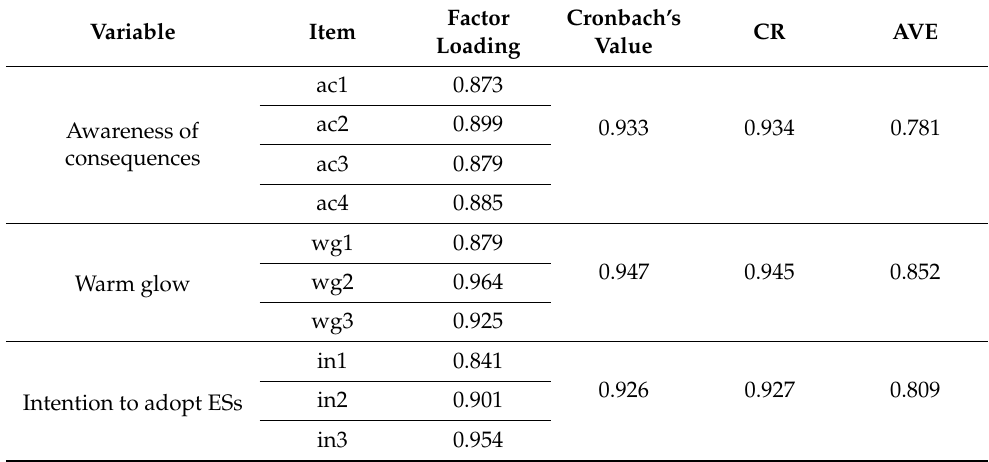
Table 1. Reliability and validity in study